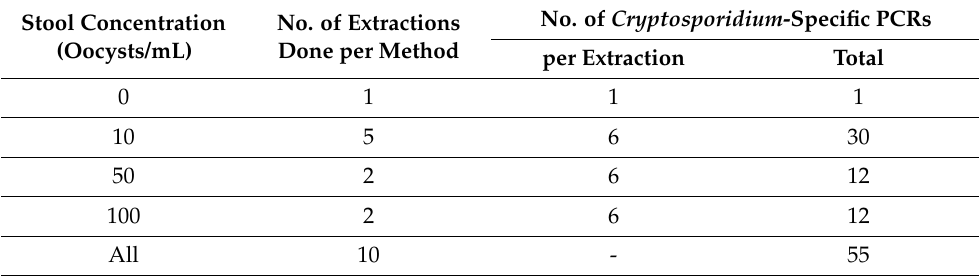
Table 1. Design of the study: the number of DNA extractions and Cryptosporidium -specific PCRs according to the parasite concentration for each of the grinding matrixes